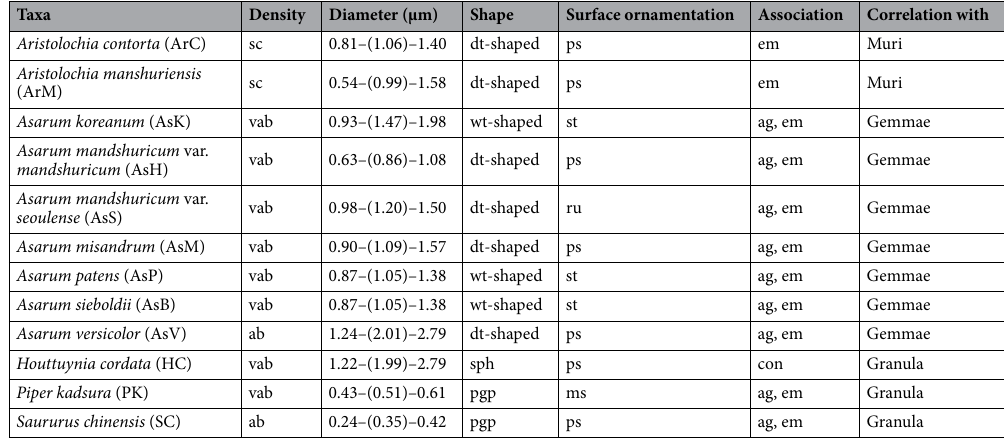
Table 2. Overview of orbicule characters in the Korean Piperales taxa. Density: ab abundant, sc scattered, vab very abundant, shape: dt-shaped dought-shaped, pgp polygonal prism, sph spherical, wt-shaped walnut- shaped, Surface ornamentation: ms microspine, ps psilate, ru regulate, st striate; association: ag aggragated, con connected via threads, em